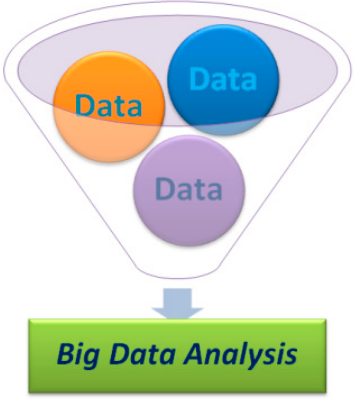
Figure 4. Big Data Analytics.